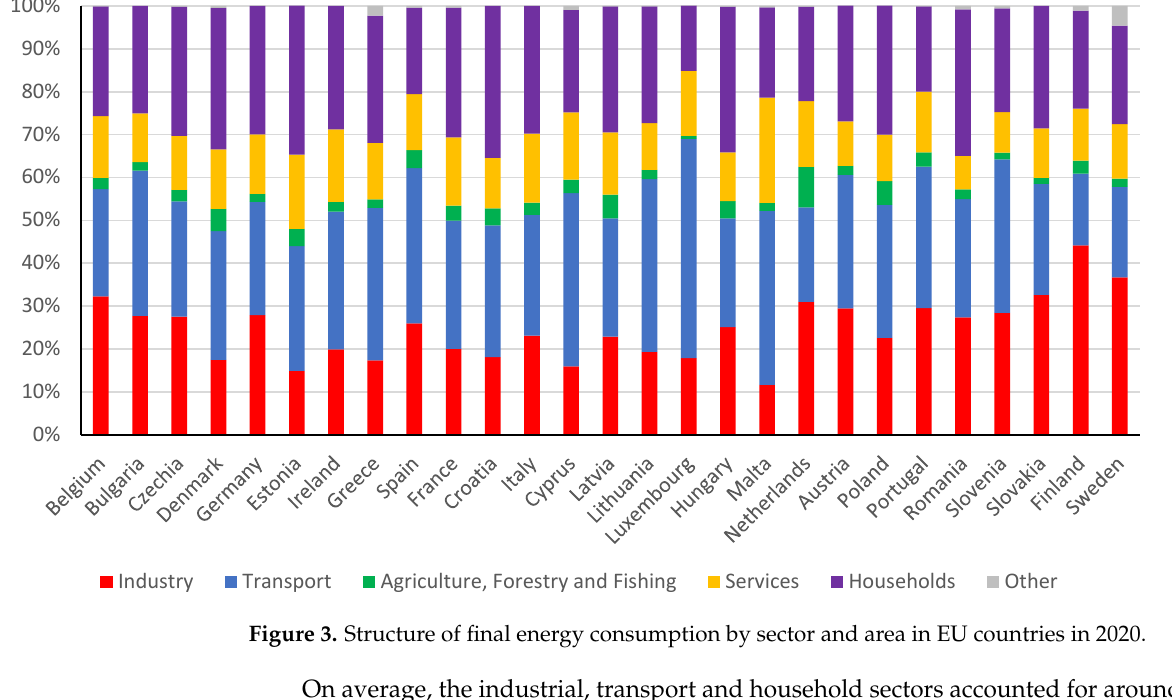
Figure 2. Final energy consumption by sector and area in EU countries from 2005 to 2020.